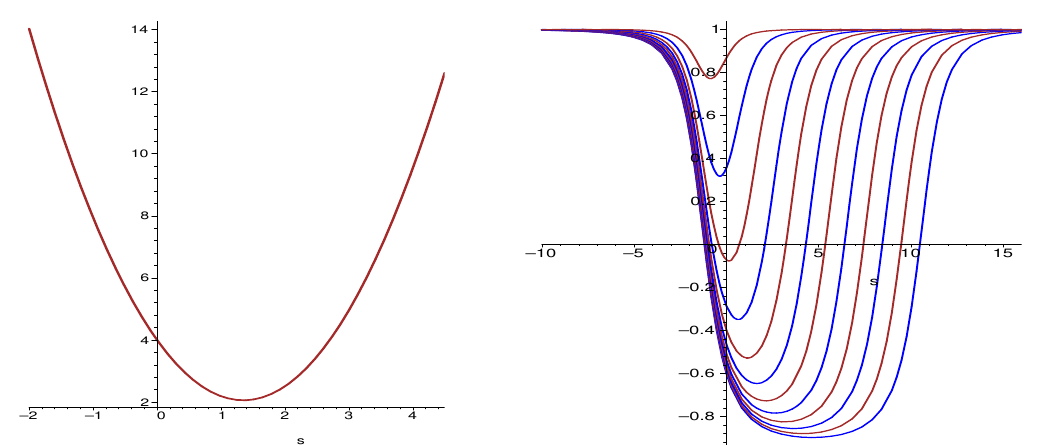
Fig. 1: The polynomial p 2 ( s ) (left) and the asymptotic correlation coefficient (right) of levels in the range 1 p O (1) : p ( s, s + ‘ ) / p ( s, s ) p ( s + ‘, s + ‘ ) for ‘ = 1 , . . . , 12 (in increasing order from top to